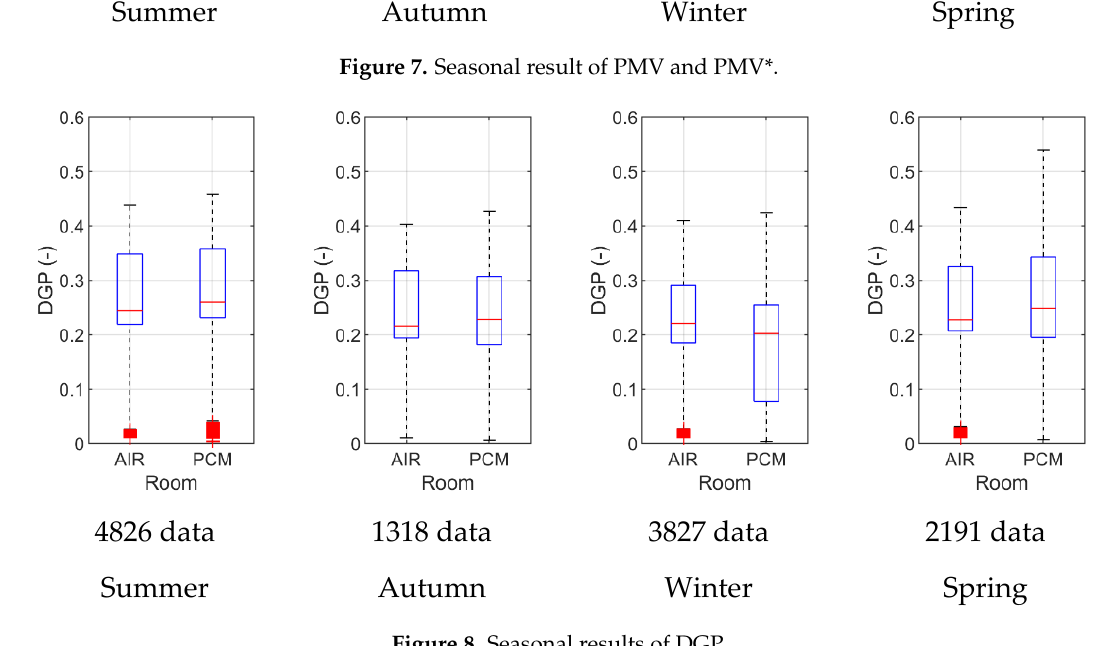
Figure 8. Seasonal results of DGP.